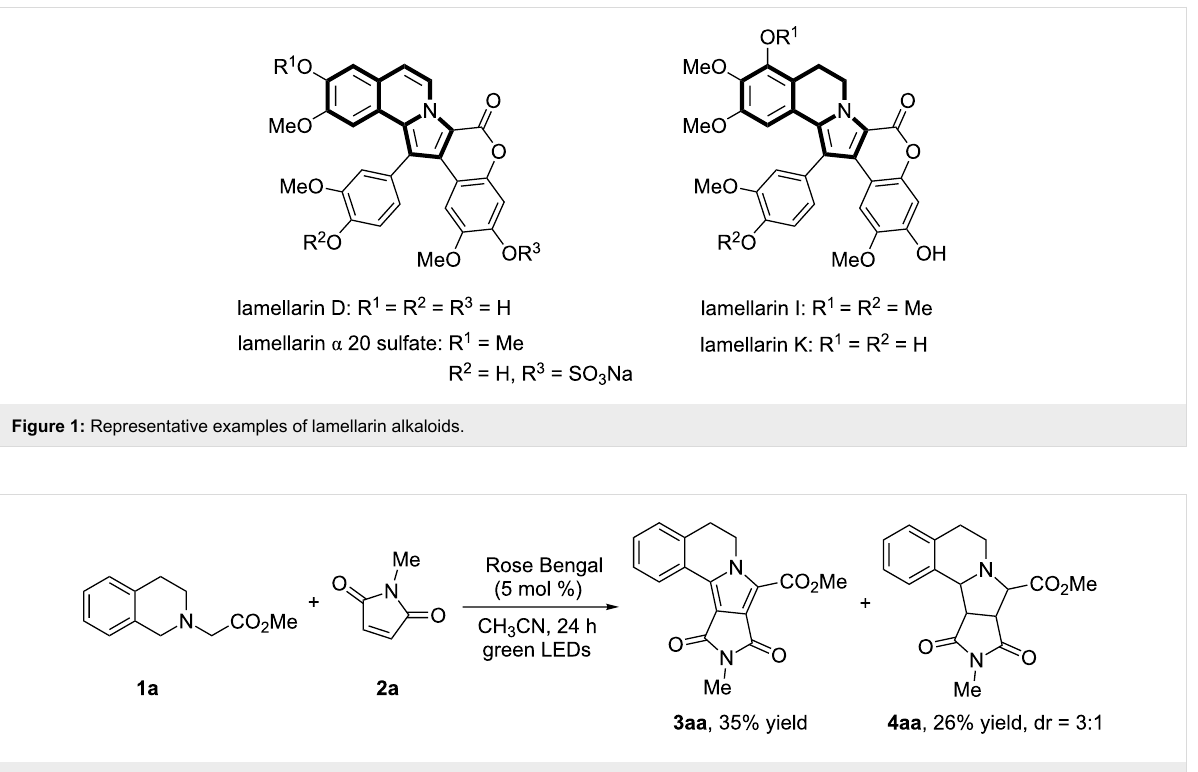
Scheme 1: Photocatalytic metal free construction of pyrrolo[2,1- a